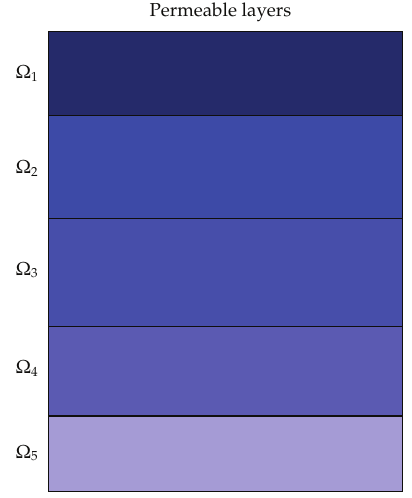
Figure 4: Electrical sectors in the domain of the